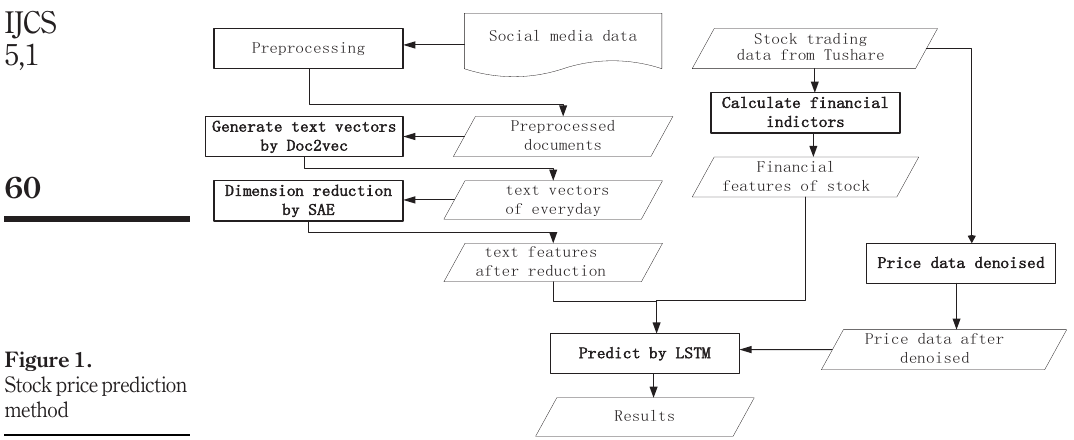
Figure 1. Stock price prediction